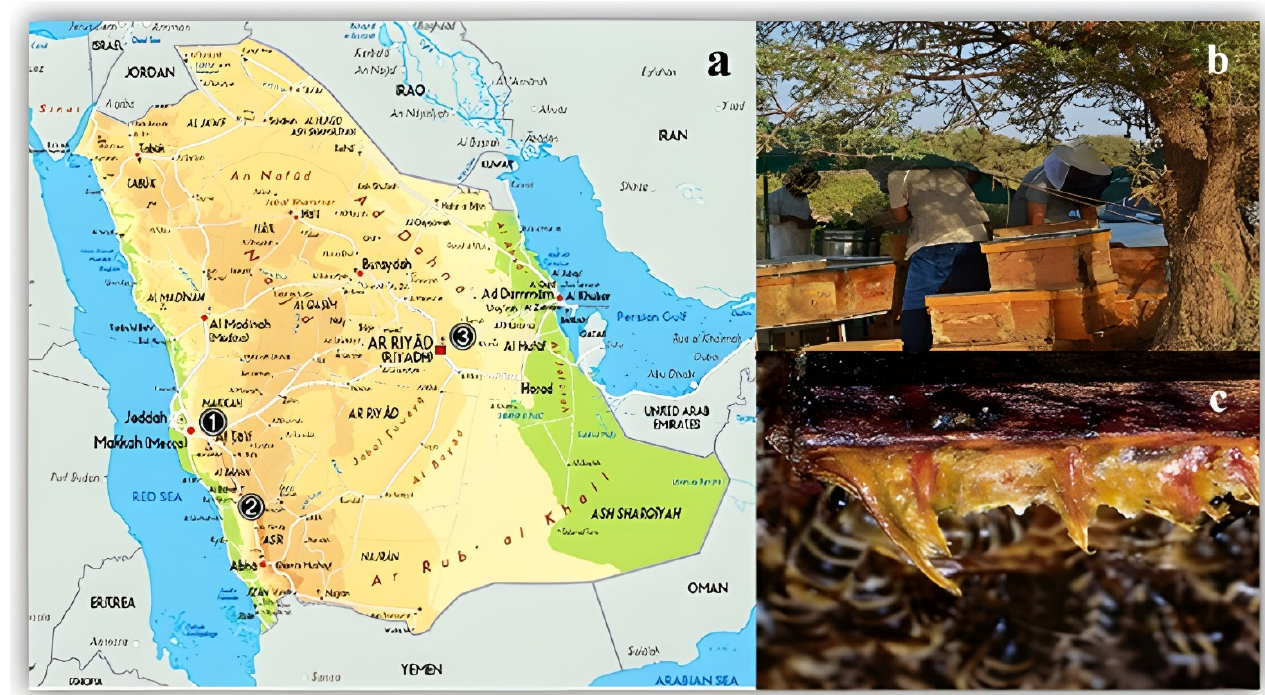
Figure 1. ( a ) Map of the Kingdom of Saudi Arabia showing the sites of the collected honeybee propolis: (1) Al Hada, Makkah; (2) Baljurashi, Baha; and (3) Rawdat Khuraim, Riyadh. ( b ) Apiculture activities on Rawdat Khuraim, Riyadh. ( c ) Edge of a traditional hive with the propolis sample, Baljurashi, Baha.